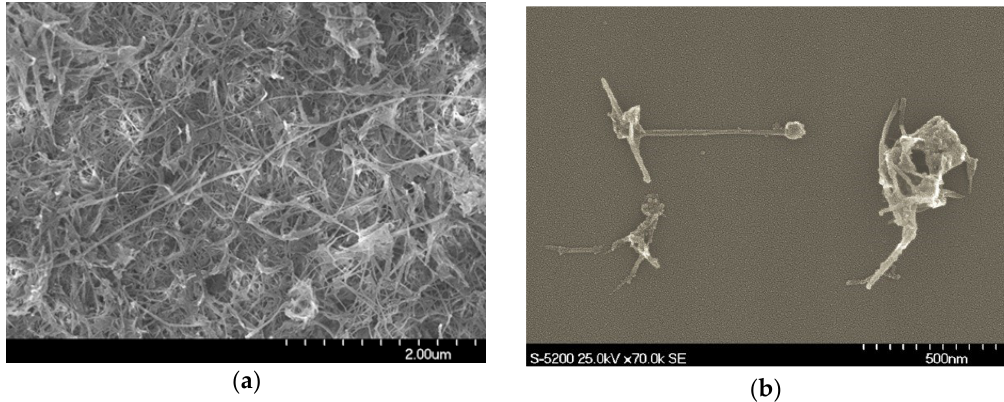
Figure 3. SEM images of ( a ) bulk BNNT material and ( b ) isolated nontube impurities.